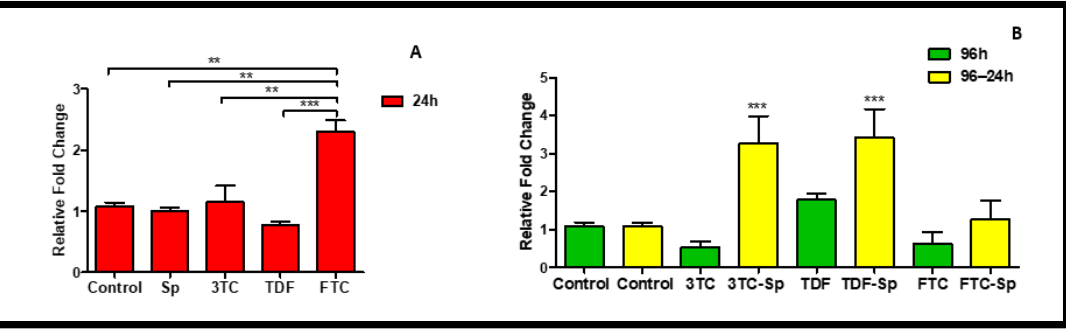
Figure 4. Effects of SP and HAART (3TC, TDF, and FTC) on Cox-1 mRNA expression. Cox-1 mRNA expression after exposure of HepG2 cells to ( A ) SP and HAART for 24 h, ( B ) HAART (96 h), and HAART (96 h) followed by SP (24 h); ** p < 0.005, *** p < 0.0001.